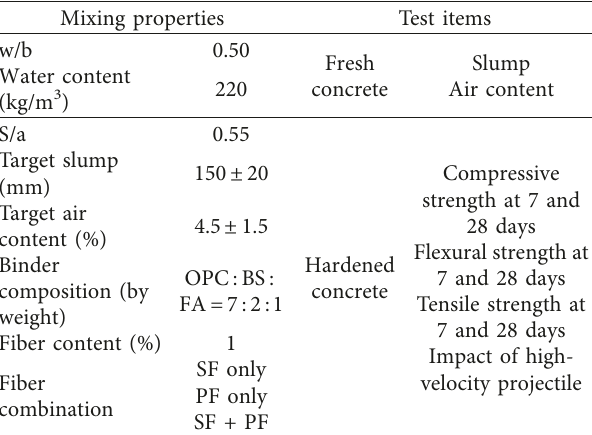
Table 1: Experimental